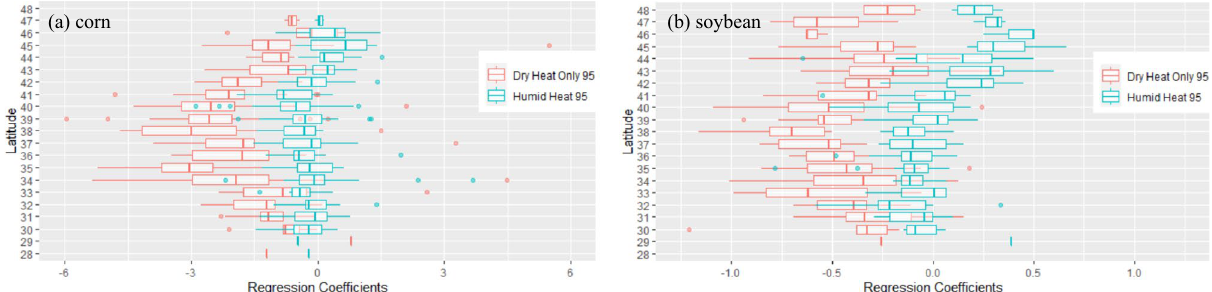
Figure 4. Latitudinal distribution of the multiple regression coefficients between yields and extreme dry/ humid heat days. Shown are the box plots of the multiple regression coefficients at each latitude for corn ( a ) and soybean ( b ) yields. The red and blue boxes indicate the interquartile range of the regression coefficients at each latitude band for dry and humid heat, respectively, the vertical lines inside the boxes indicate the median values, and the horizontal lines (whiskers) indicate the ranges of the regressions. Dots are outliers.